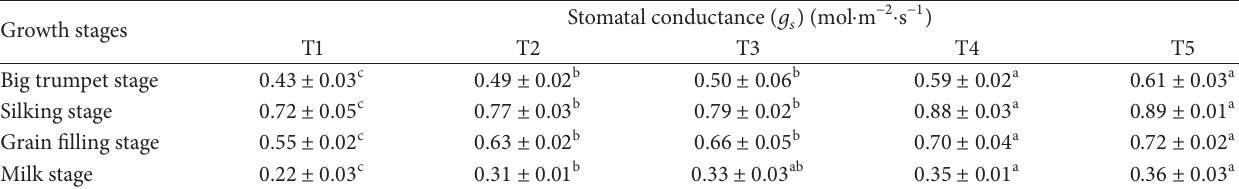
Table 6: Effects of silicon on intercellular CO